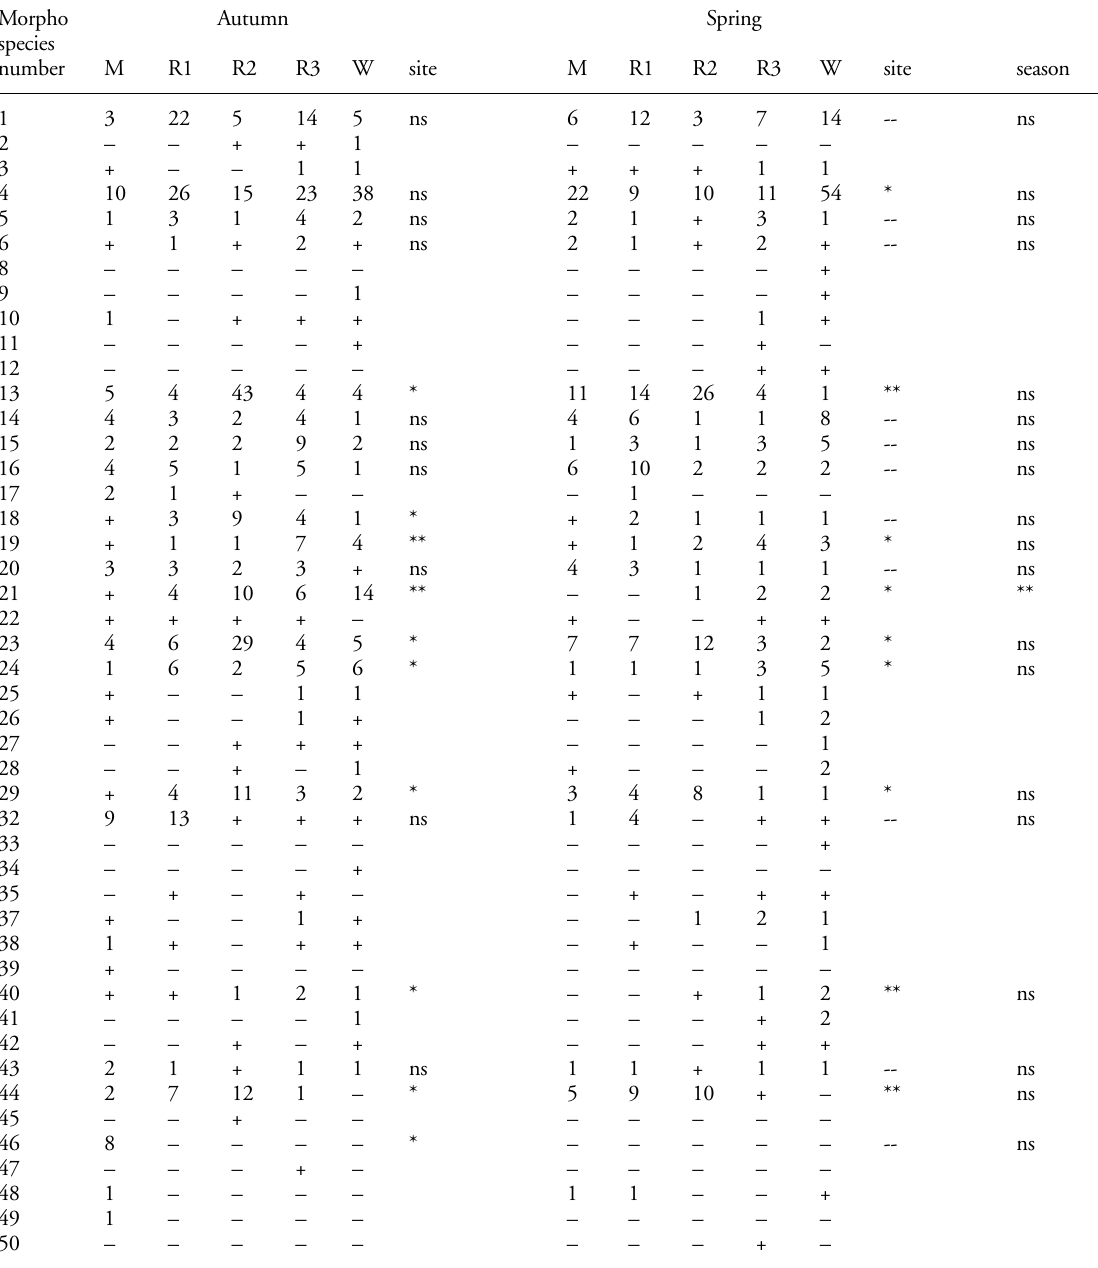
Table 1. Mean population density (individuals × 10 3 m –2 ) of oribatid morphospecies found at Loch Garten transect sites during autumn 1998 and spring 1999. (Mean densities given to the nearest integer. Mean values < 0.5 represented by + and a zero value by –). Also shown are non-parametric test results examining differences in the twenty most abundant morphospecies between sites during each season (site) and between seasons (season). A space indicates the analysis was not carried out. (*: differences significant at p< 0.05, **: differences significant at p< 0.01, ns: no significant difference).